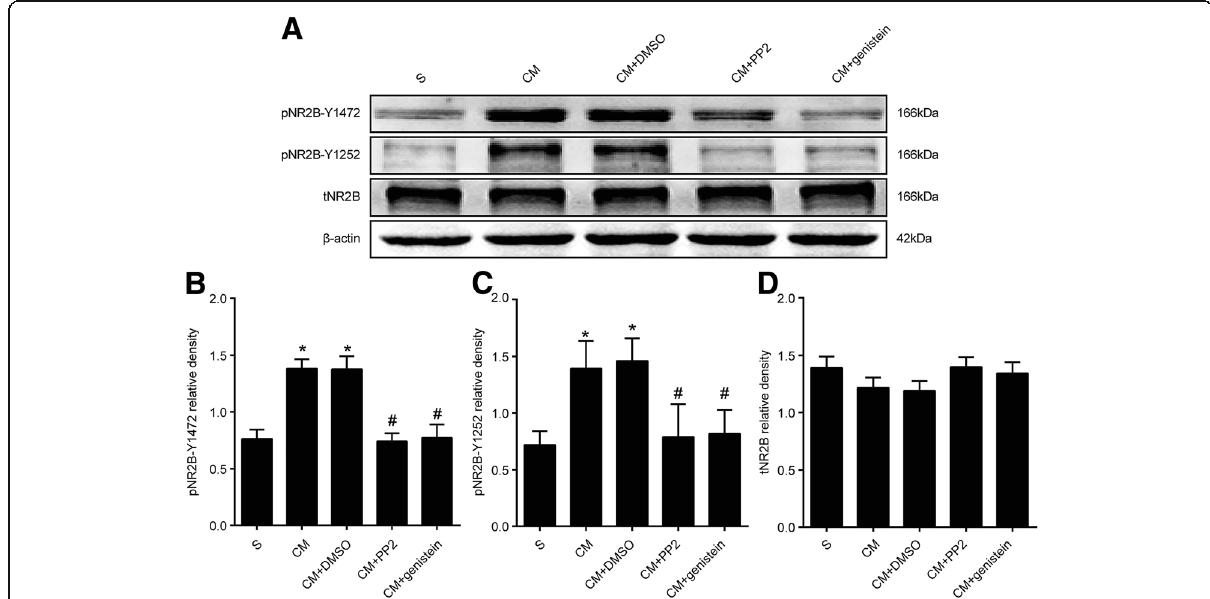
Fig. 4 Expression of phosphorylated NR2B (pNR2B-Y1472 and pNR2B-Y1252) and tNR2B in each group. a The four rows show tNR2B, pNR2B- Y1472, pNR2B-Y1252 and β -actin. b The protein levels of pNR2B-Y1472 in the TNC were higher in the CM group than in the sham group. Compared with that found in the CM + DMSO group, PP2 and genistein significantly decreased the levels of pNR2B-Y1472. c The protein levels of pNR2B-Y1252 in the TNC were higher in the CM group than in the sham group. Compared with that found for the CM + DMSO group, PP2 and genistein significantly decreased the level of pNR2B-Y1252. d There was no significant difference in the expression of tNR2B among the different groups ( n = 6 in each group, * P < 0.05 compared with the sham group, # P < 0.05 compared with the CM + DMSO